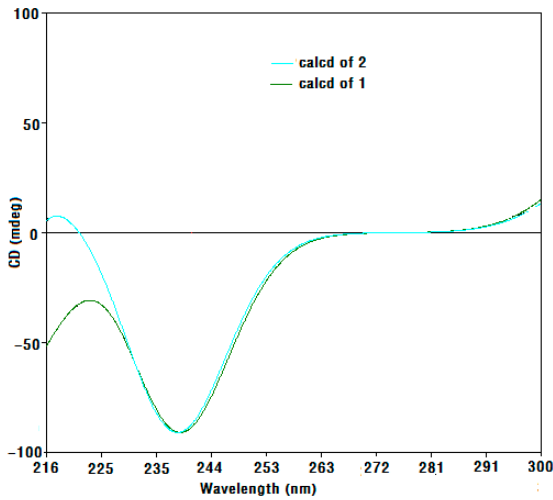
Figure 4. Calculated circular dichroism (CD) spectra of compounds 1 and 2 .